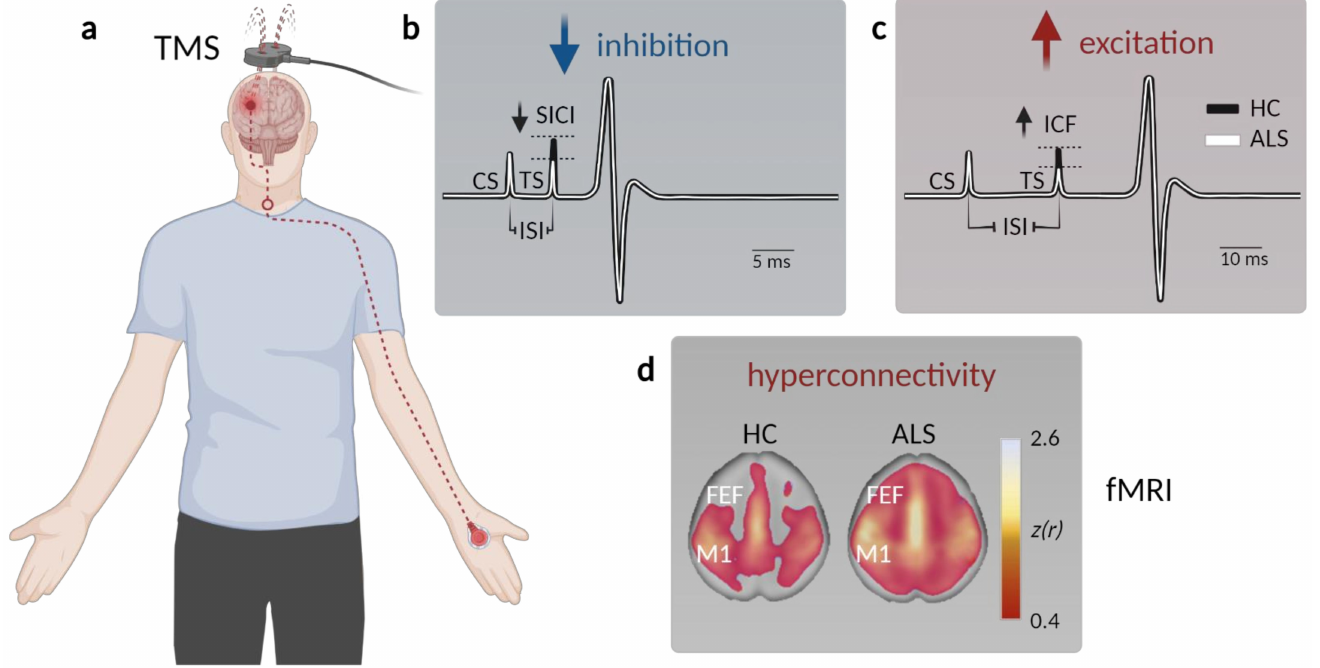
Figure 1. Assessment of motor cortex hyperexcitability and hyperconnectivity in ALS patients. ( a ) Schematic displaying paired-pulse transcranial magnetic stimulation (TMS) in patients. A